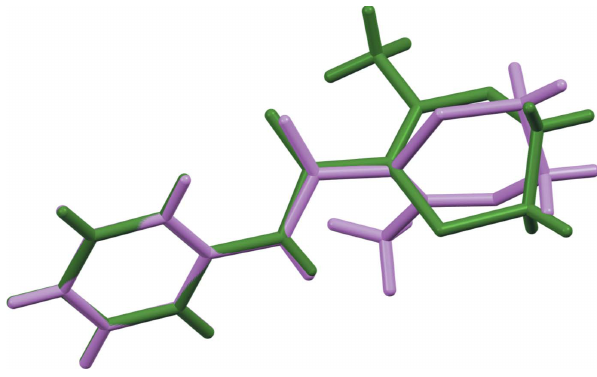
Figure 3 View of the structure overlay of molecule A (violet) and molecule B (green) from the form 1 structure.